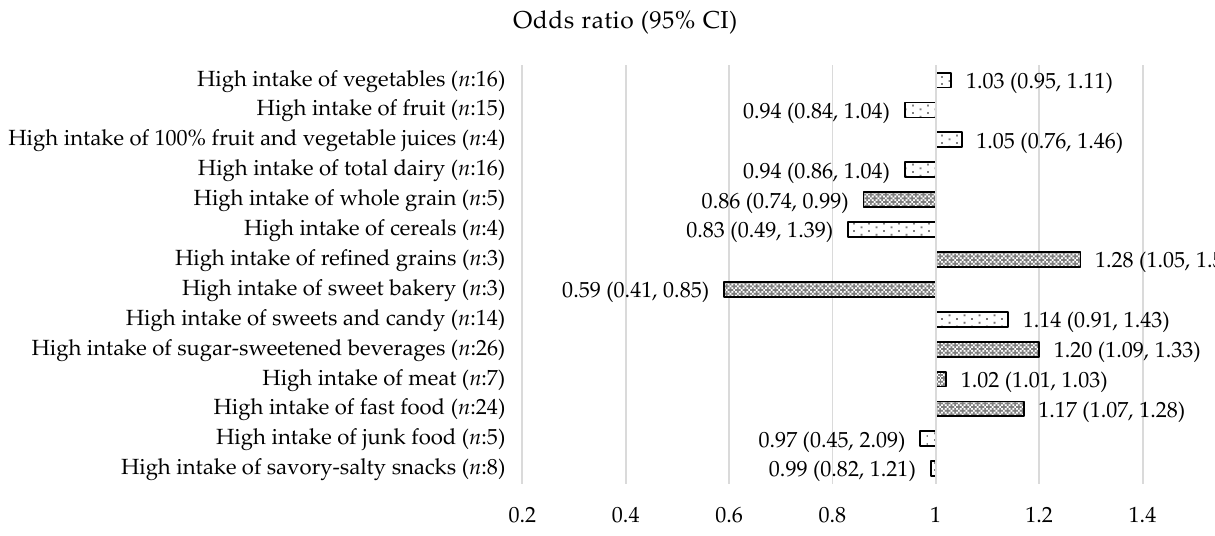
Figure 2. Association between a high intake of 14 different food and beverages categories and risk of overweight/obesity in children and adolescents 5–18 years. OR < 1 = decreased risk of overweight/obesity, OR > 1 = increased risk of overweight/obesity. Dark shades are significant ( p ≤ 0.05). White shades are not significant. The forest-plots for each food or beverages category is available in Supplementary Figures S1–S15.